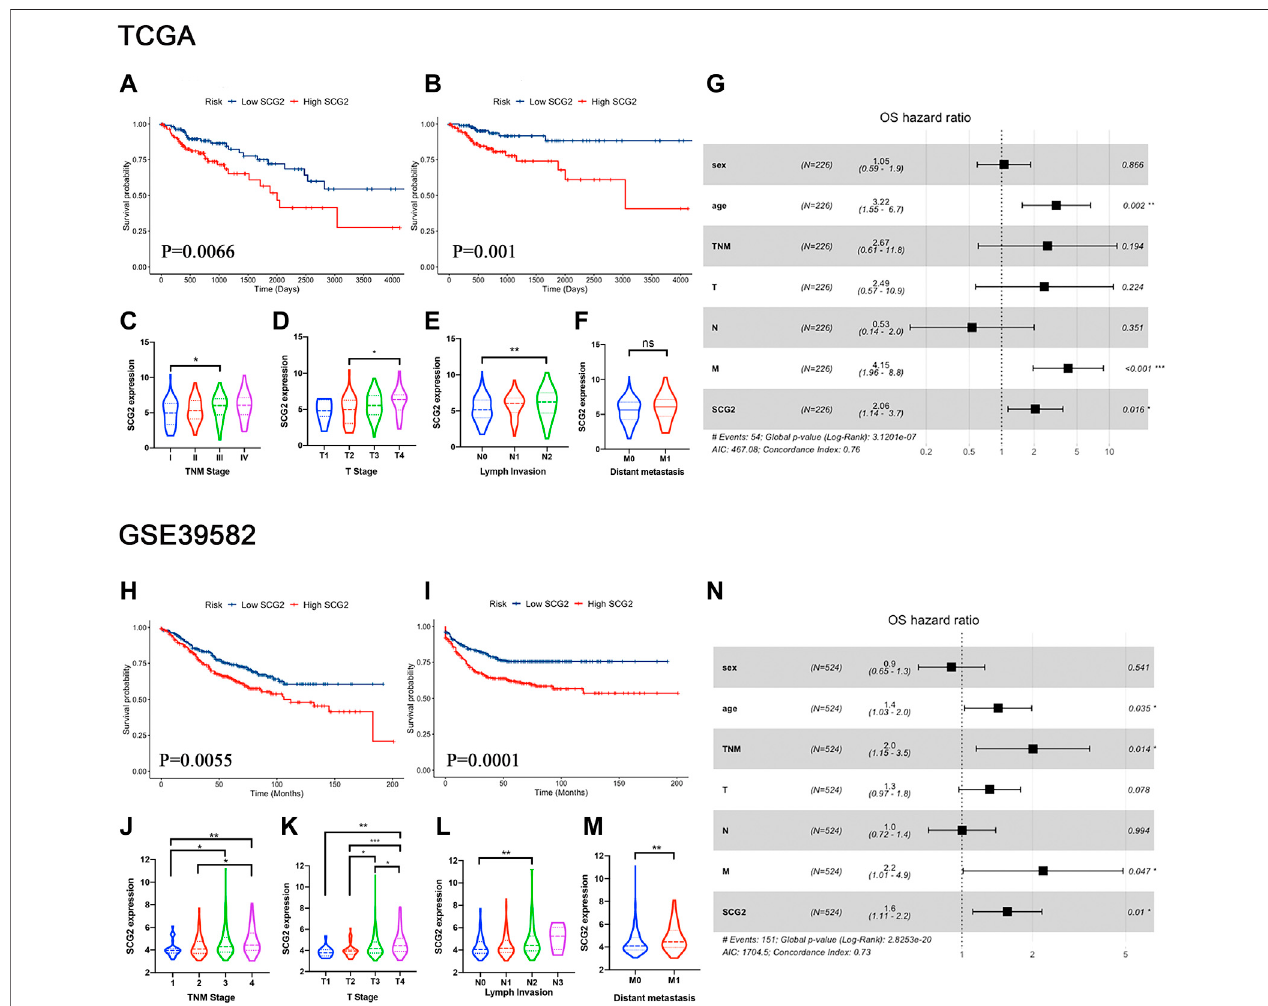
FIGURE 3 | High SCG2 expression is associated with worse survival and advanced clinical stage in CRC patients. (A,B) OS, DFS in the TCGA CRC cohort. (C – F) SCG2 expression was higher in patients of advanced T, N, M, TNM stage in the TCGA CRC cohort. (G) Multivariate Cox analysis of patients in the TCGA CRC cohort showingtheHRsofdifferentfactors. (H,I) OS,DFSintheGSE39582CRCcohort. (J – M) SCG2expressionwashigherinpatientsofadvanced T,N,M,TNMstageinthe GSE39582CRCcohort. (N) MultivariateCoxanalysisofpatientsintheGSE39582CRCcohortshowingtheHRsofdifferentfactors.HRs,hazardratios. (C – E,J – L) Examined by Kruskal-Wallis H test; (F,M) Examined by Mann-Whitney U test; * p < 0.05, ** p < 0.01, *** p <